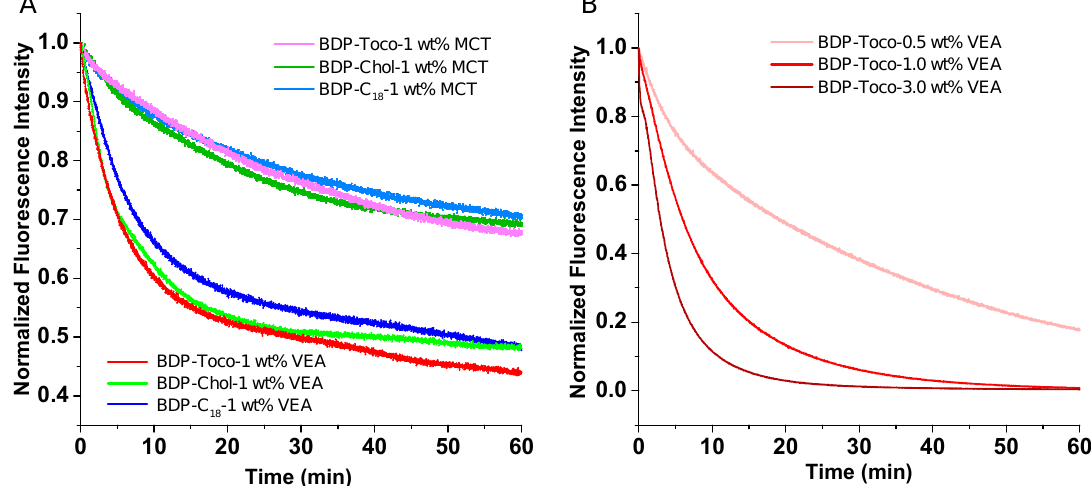
Figure 5. ( A ) Photostability of 1 wt % dye-loaded NEs under continuous illumination. ( B ) Photostability of BDP-Toco loaded NEs with increase in loading wt % under continuous illumination. λ Ex was 470 nm for A and 500 nm for B. The fluorescence was monitored at 600 nm.